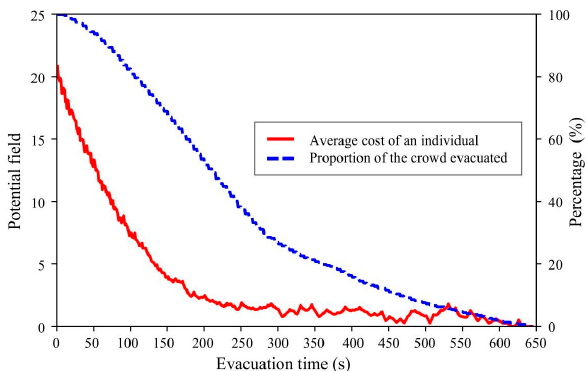
Figure 7. Individual actual potential field to targeted exit and proportion of the crowd evacuated during evacuation process.